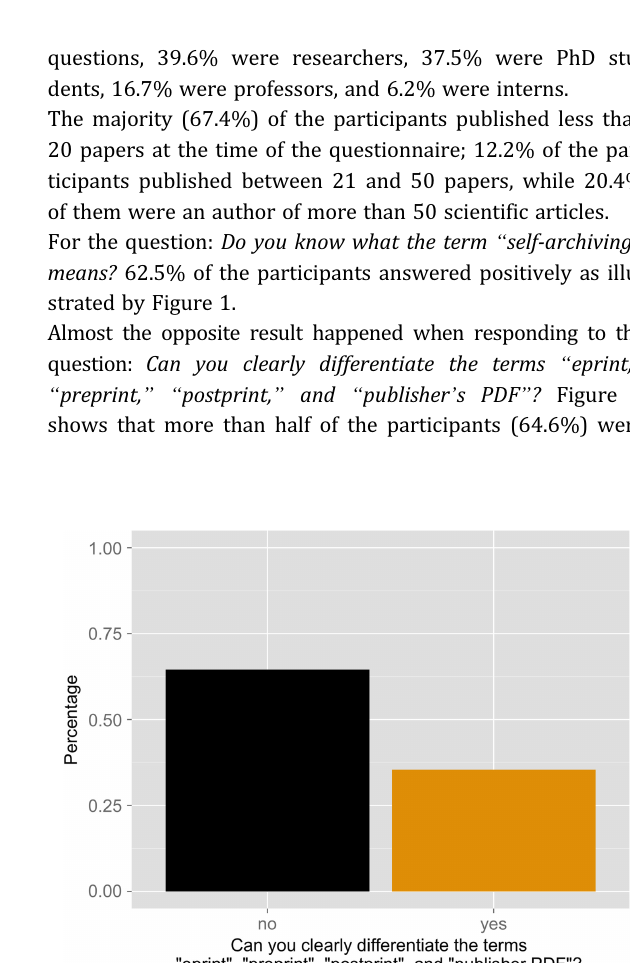
Figure 1. Answers to the question: Do you know what the term “ self-archiving ” means?